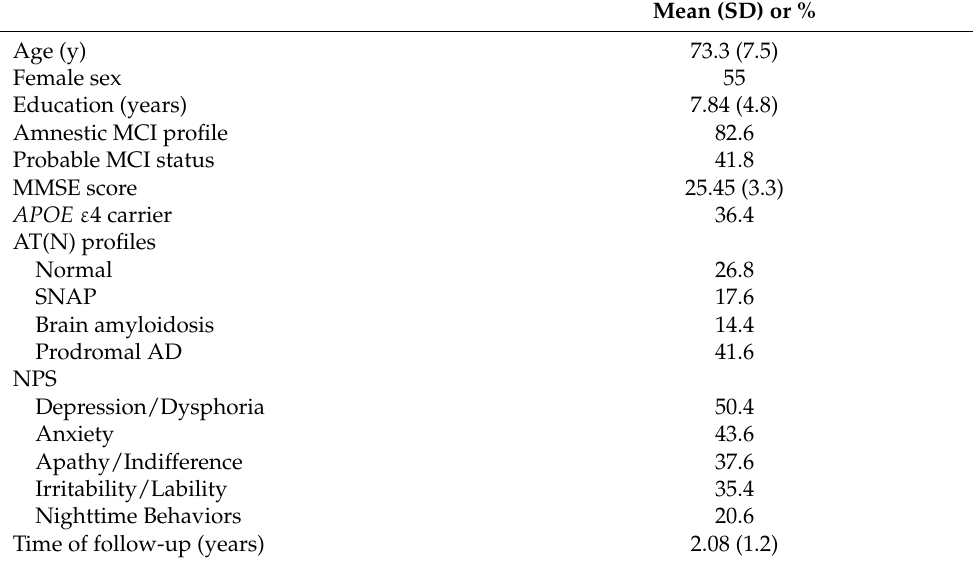
Table 1. Demographic and clinical characteristics of the study participants ( n =